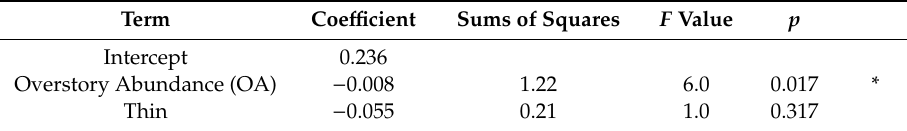
Table A3. Model results for basal area increment (BAI), an aspect of overstory dynamics, during the Early to Late interval ( n = 72 plots). BAI was analyzed with a LM. The total sums of squares for the model was